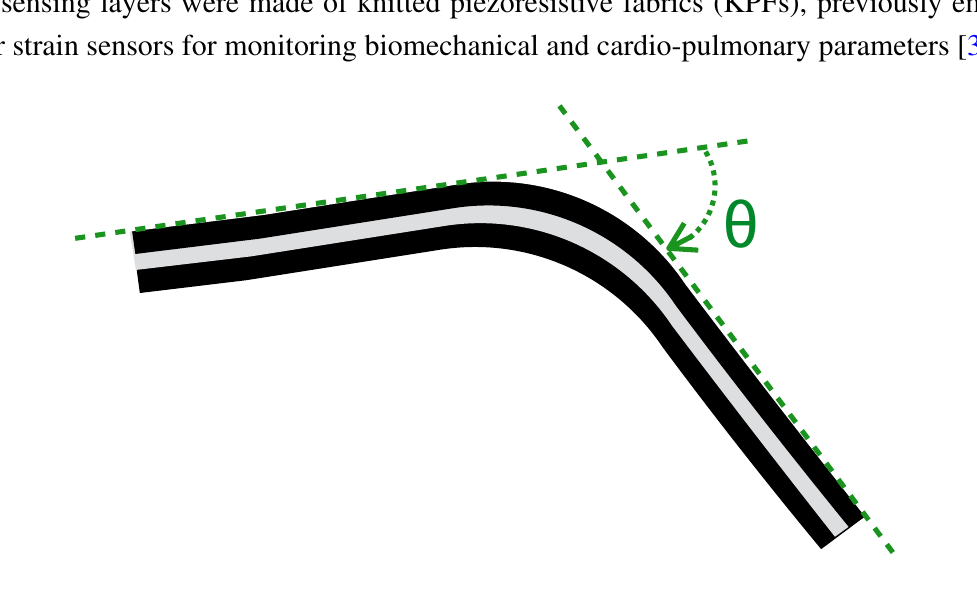
Figure 2. Schematic diagram of a double-layer KPF goniometer. The black stripes represent the two identical piezoresistive layers, while the gray stripe is the insulating layer. When the sensor is in the flat position, the resistance difference ( ∆ R ) between the two layers is zero. When the sensor is flexed, ∆ R is proportional to the bending angle ( θ ), defined as the angle between the tangent planes to the sensor extremities (green dashed line in the